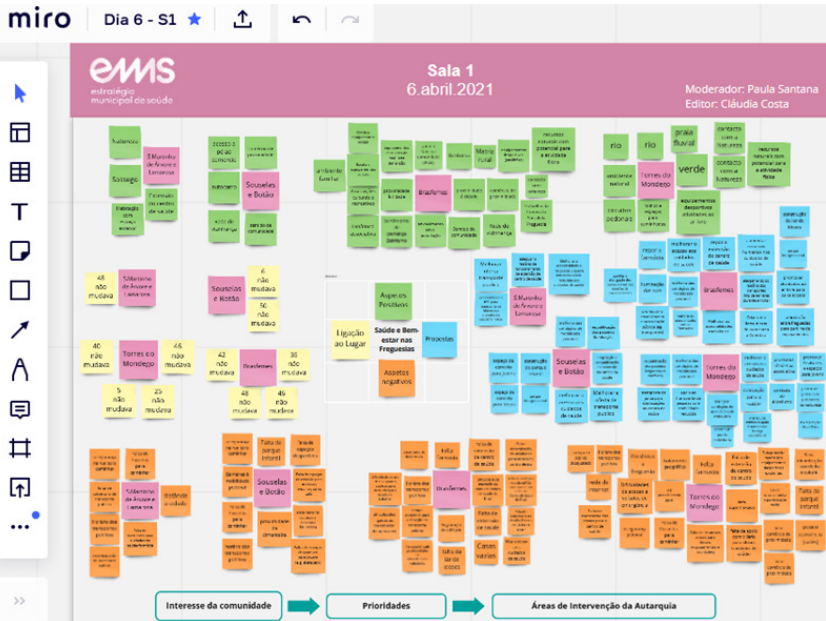
Figure 6. Lotus diagram representing the proposals of citizens in the collaborative session dedicated to rural civil parishes (illustrative example). Note: In the center of the diagram is the central theme (health and well‐being in the civil parish), and then the digital sticky notes are expanded outwards in an iterative manner with the proposed solution areas. Source: Câmara Municipal de Coimbra and University of Coimbra